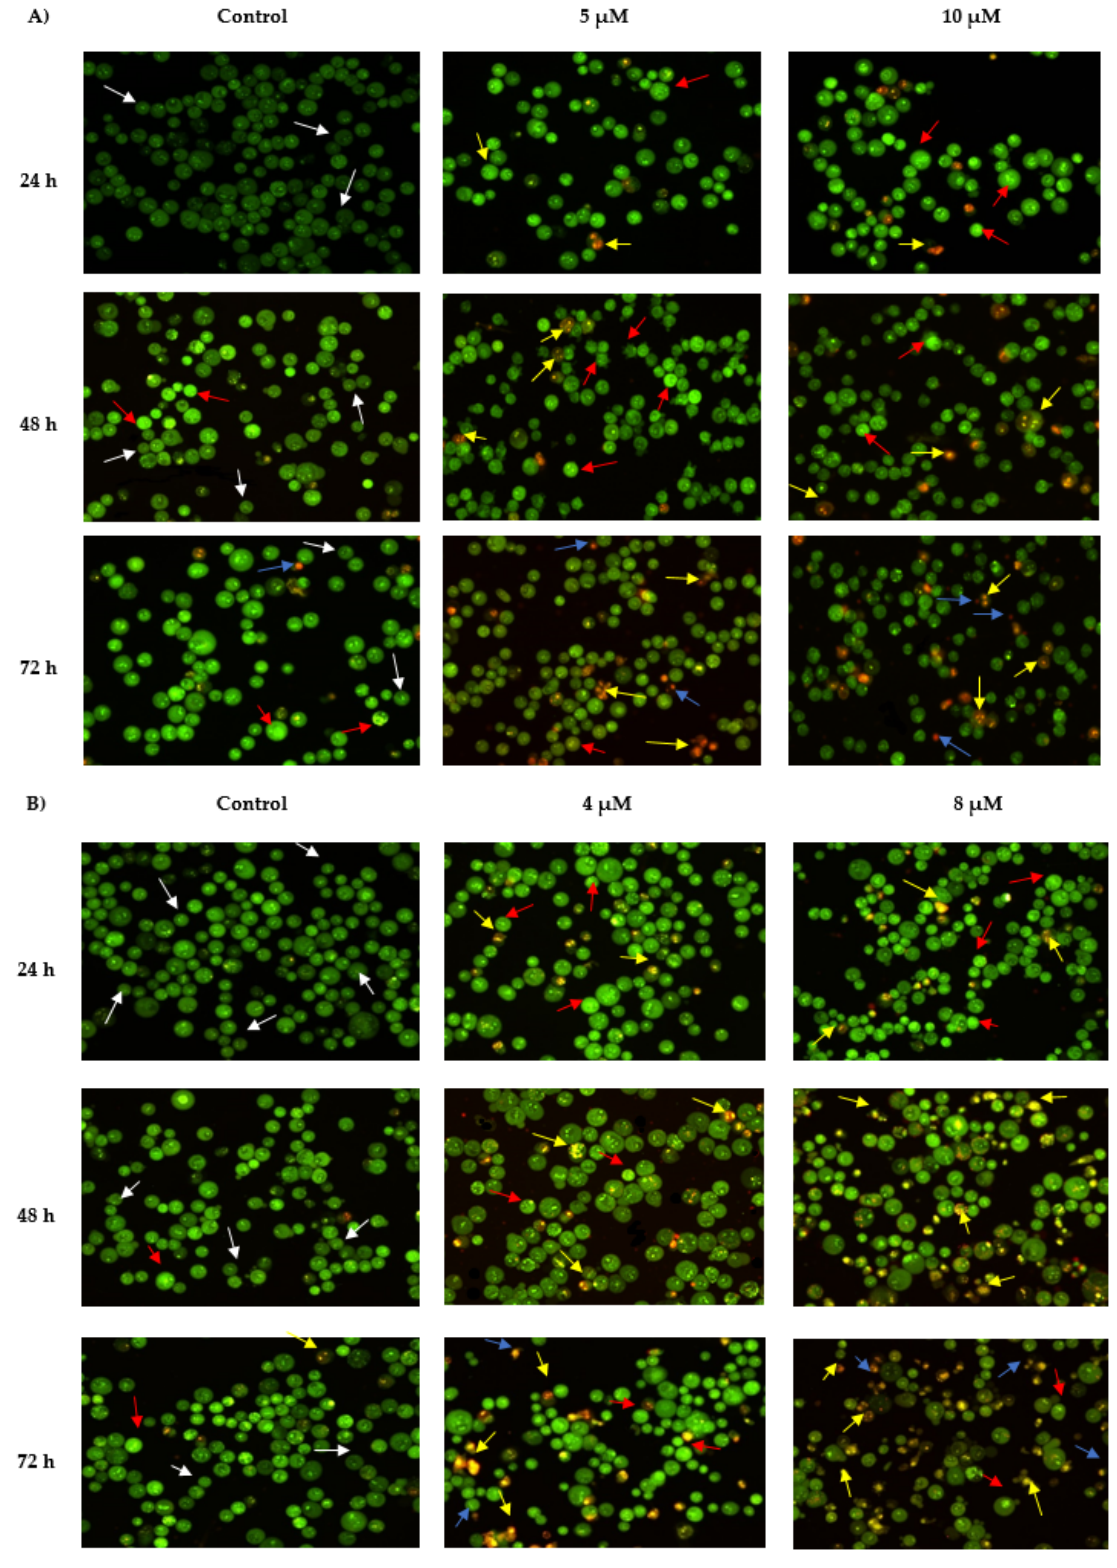
Figure 4. Detection by fluorescent microscope of acridine orange/propidium iodide double stained ( A ) NCI-H520 and ( B ) NCI-H23 cells treated with MS13 for 24, 48, and 72 h. Untreated viable cells are uniformly pale-green (white arrow). Early apoptotic cells showed characteristic loss of membrane integrity, membrane blebbing, and chromatin condensation, stained bright-green (red arrow). Late apoptotic cells stained yellow-orange to bright red, with a condensed or fragmented chromatin (yellow arrow). Necrotic cells showed orange or red uniform nuclei (blue arrow). Magnification is at 100×.